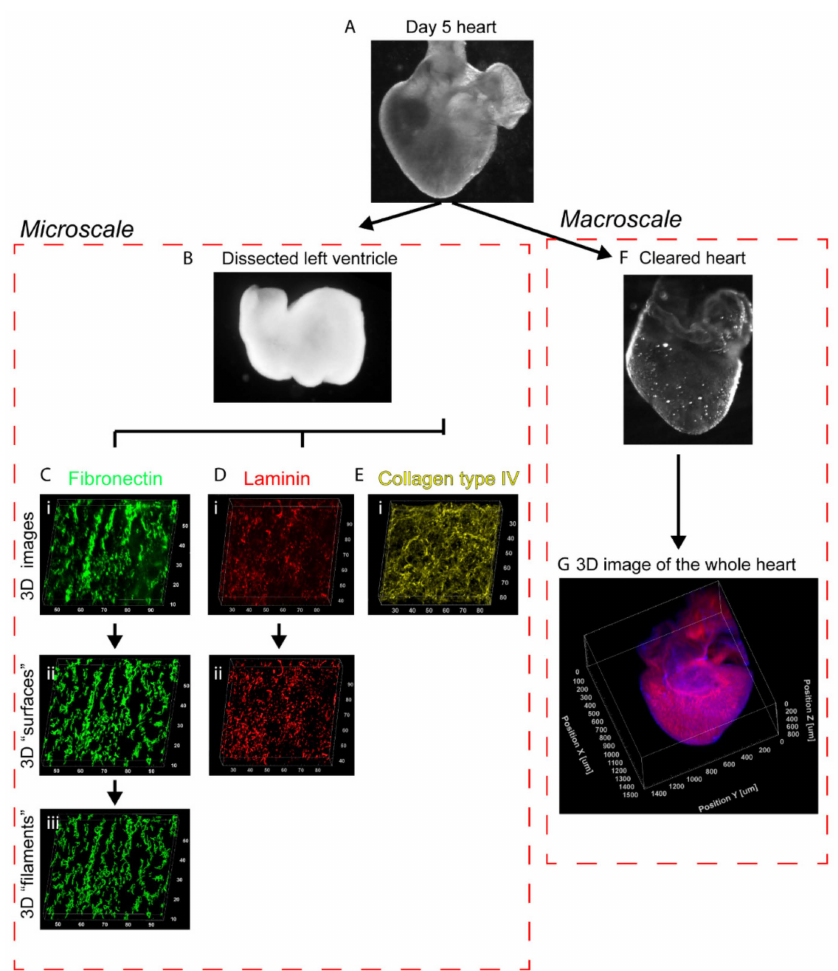
Figure 1. Schematic of the process to image and analyze the embryonic myocardium at the microscale and macroscale. ( A ) Chick embryonic hearts were dissected, fixed, and stained at di ff erent stages of development. ( B ) To study the extracellular matrix (ECM) at the microscale, the left ventricle was dissected and opened to lay flat. ( C – E , i) High-resolution 3D images of the fibronectin, laminin, and collagen type IV ECM were obtained by confocal microscopy. ( C , D , ii) The fibronectin and laminin images were segmented to create 3D surface objects to characterize the volume and spacing. ( C , iii) The fibronectin images were further processed to create 3D filaments objects used to measure fiber diameter, length and orientation. ( F ) Hearts were also whole mounted in a 1:2 solution of benzyl alcohol to benzyl benzoate (BABB), a refractive index matching solution to clear the tissue. ( G ) 3D images of the whole heart, showing detailed trabeculae, were obtained using a macrozoom confocal